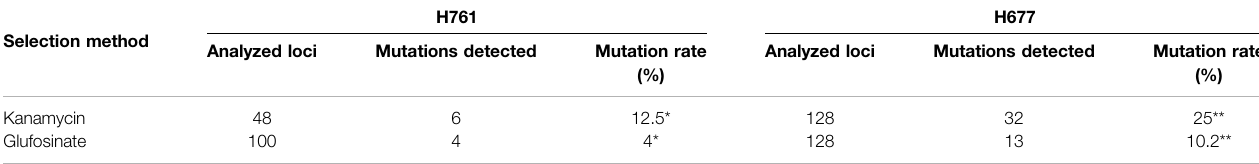
TABLE1| Editingfrequenciesofthetargetgenein Arabidopsis seedlingstransformedwithH761orH677subjectedtokanamycinorglufosinateselection(Chi-squaredtest: * p < 0.1, ** p < 0.002).